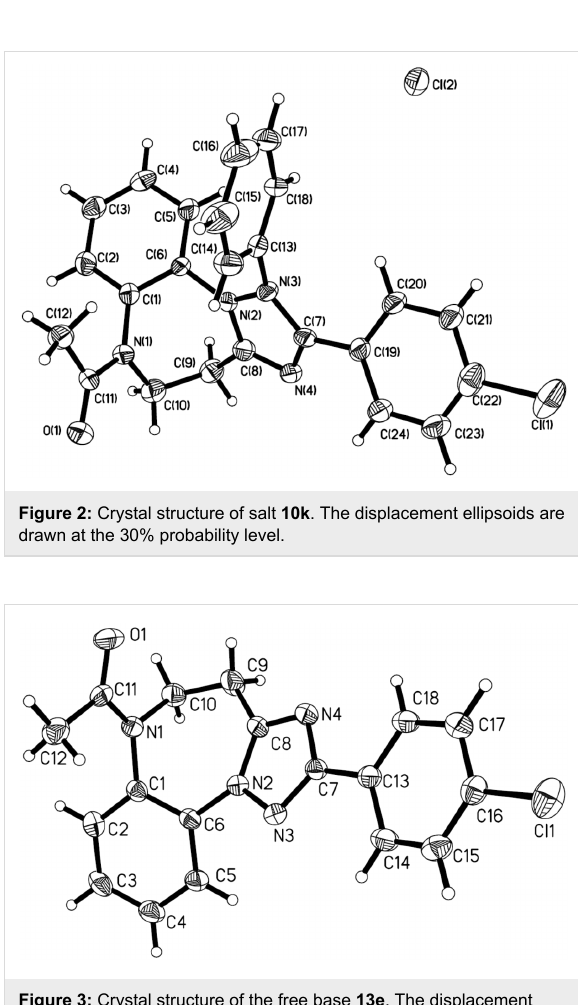
Figure 3: Crystal structure of the free base 13e . The displacement ellipsoids are drawn at the 30% probability